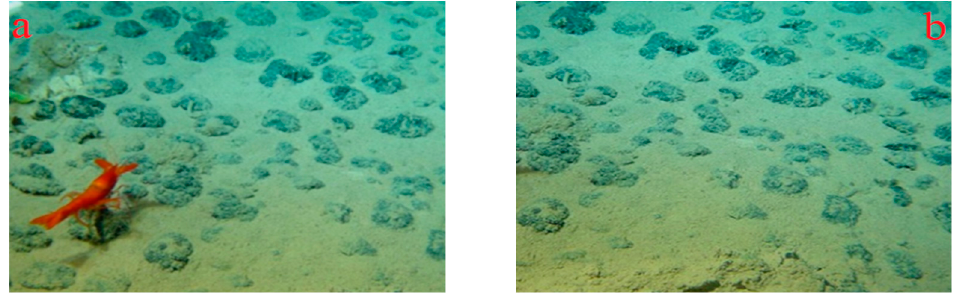
fused images showed no stitching traces.